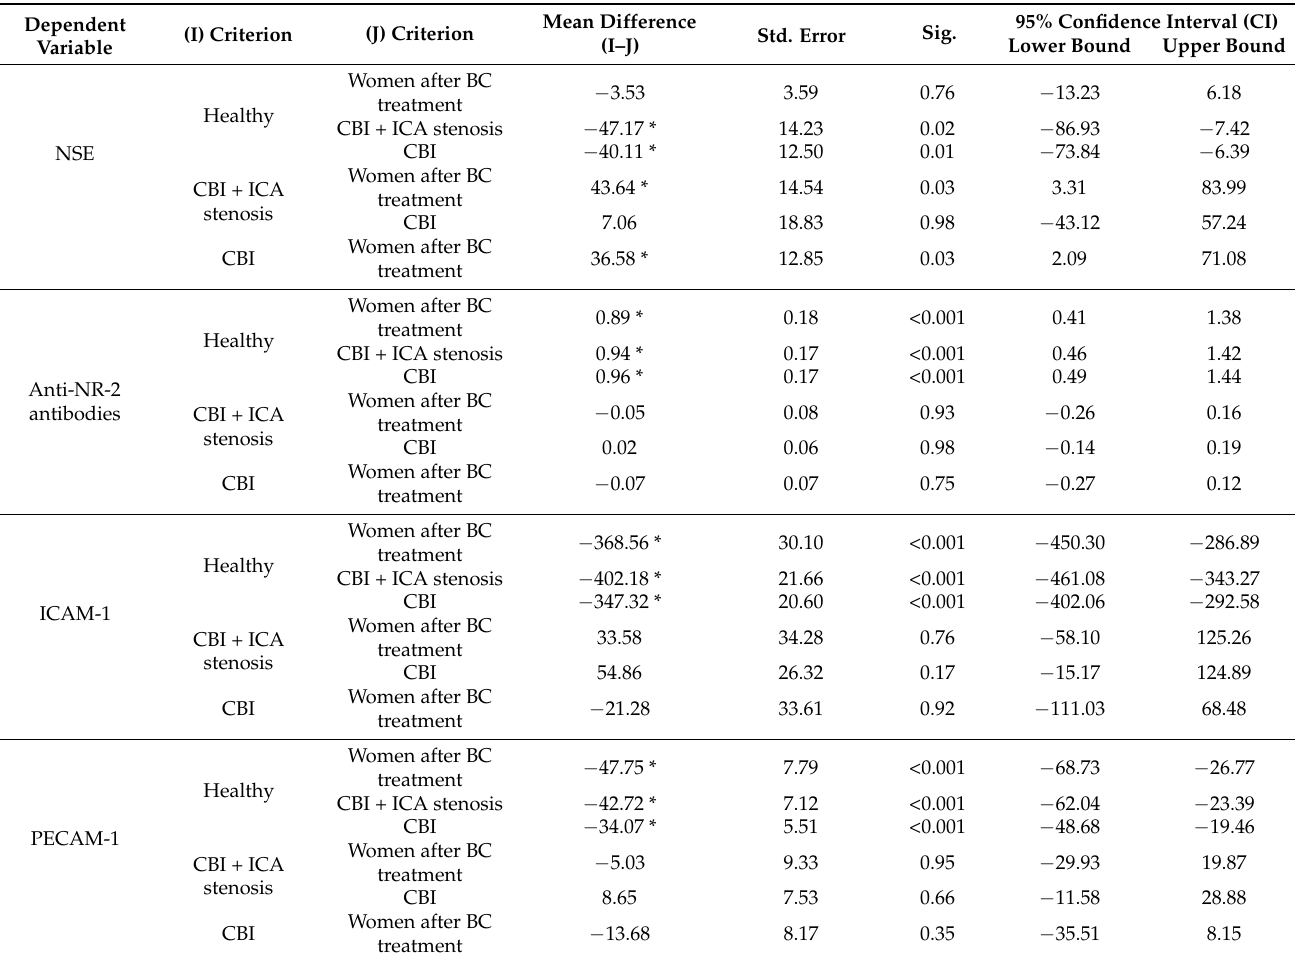
Table 6. Games–Howell test result for two groups according to a certain